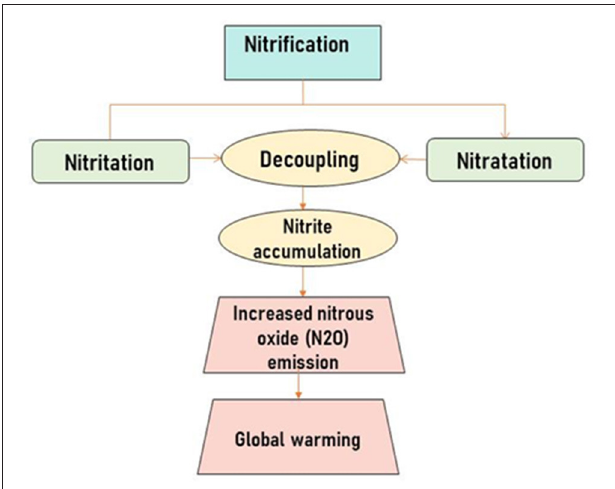
FIGURE 3 | Decoupling in soil nitrification process resulting to global